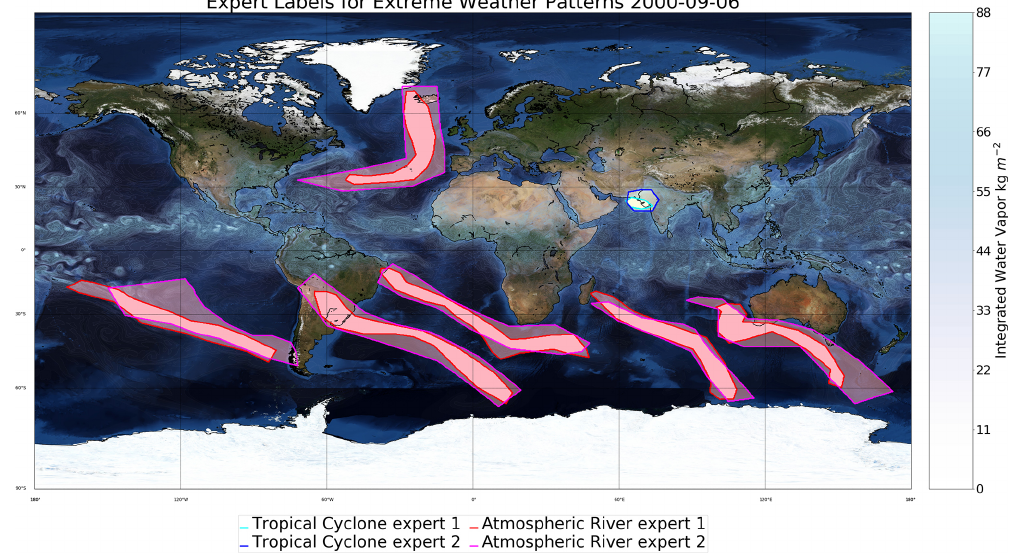
Figure 8. Comparison of two different expert labelings with an IoU of 0.59. Note that – even though, visually, the experts appear to agree to a large extent on their labels of AR and TC events in this snapshot – the quantitative IoU metric is only 0.59. Hence we emphasize that IoU not be confused with accuracy; good agreement even amongst expert labelers can result in IoU values far from unity. A perfect match (i.e., IoU = 1) only results when two labelers agree on every single pixel of the image. As is apparent from this figure, even relatively minor differences in the labels for TCs can disproportionately impact the mean IoU. The “bluemarble” map in the background included via Matplotlib’s Basemap library is © NASA. Table 3. Scaling relationships for global tropical cyclone precipitation at various percentiles for extremes. The tropical (40 ◦ S–40 ◦ N) mean SST increases by 1.6K from 297.4K (All-Hist) to 299.0K (UNHAPPI). CC scaling for this temperature increase would be 11.2%. Note that extreme precipitation at the 95th percentile and higher exceeds CC scaling with increases about